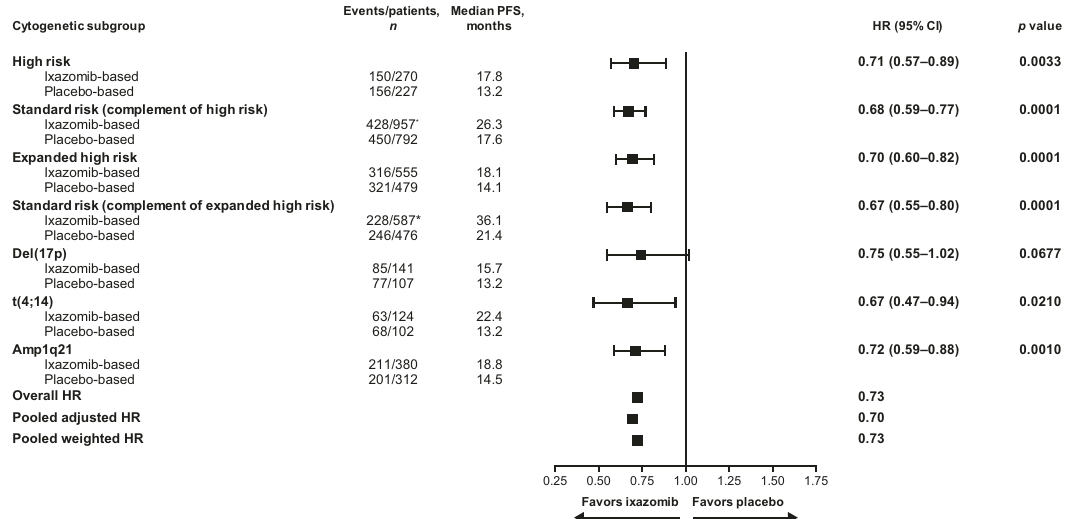
Fig. 5 Forest plot of PFS with ixazomib- vs placebo-based therapy regardless of cytogenetic risk strati fi ed by study. Sensitivity analysis conducted by aggregating strati fi ed HR from the individual studies (weighted method to calculate overall HR), to accommodate for potential confounding factors arising from the differing study designs. Patients who were alive or who had not progressed at the data cut-off were censored on the day of last contact. High-risk subgroup: presence of one or more of del(17p), t(4;14) or t(14;16) cytogenetic abnormalities; expanded high-risk subgroup: presence of any of the above and/or amp1q21; complementary standard-risk subgroups: patients without any of the speci fi ed cytogenetic abnormalities listed above for high-risk and expanded high-risk. *1 patient was not included in the analysis due to inadequate sampling for cytogenetic assessment. CI con fi dence interval, HR hazard ratio, PFS progression-free